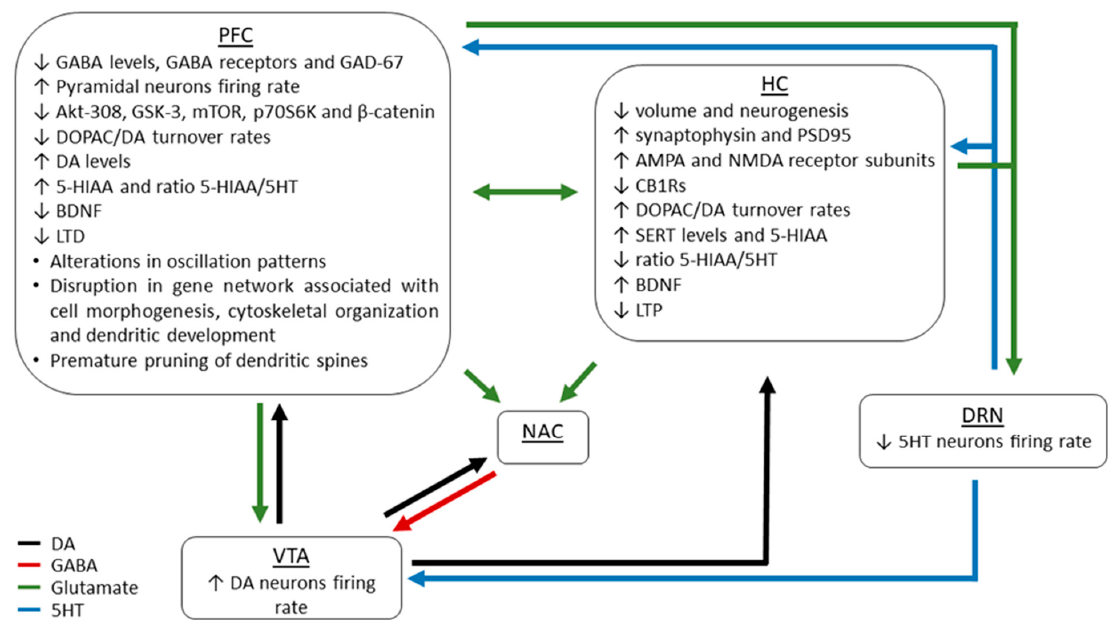
Figure 1. Schematic circuit diagram illustrating the long-lasting alterations in brain regions affected by adolescent THC exposure.